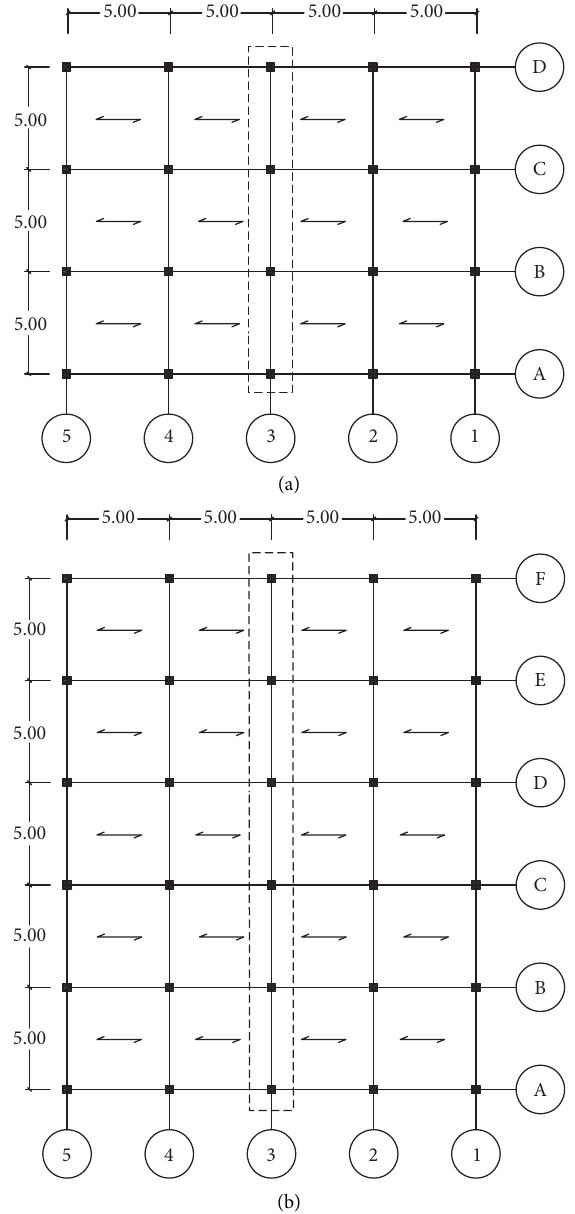
Figure 2: Plan view of the buildings containing the studied